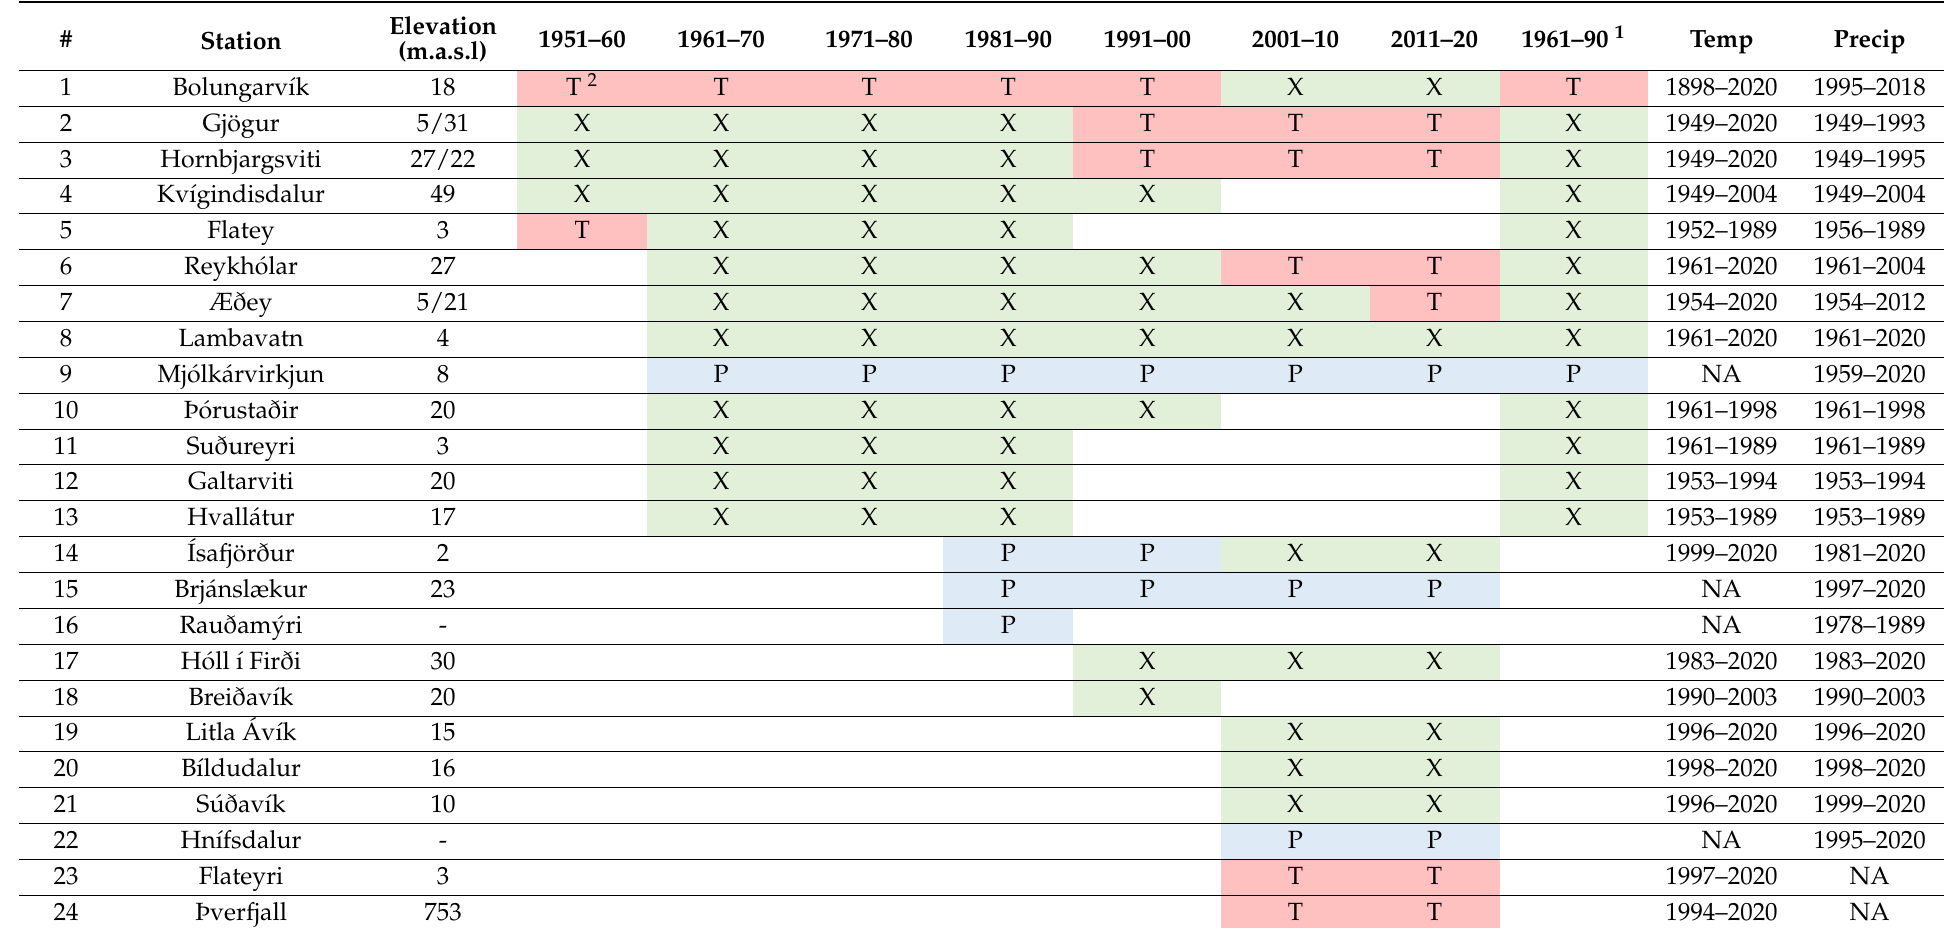
Table 1. Summary of temperature and precipitation data availability for the Westfjords